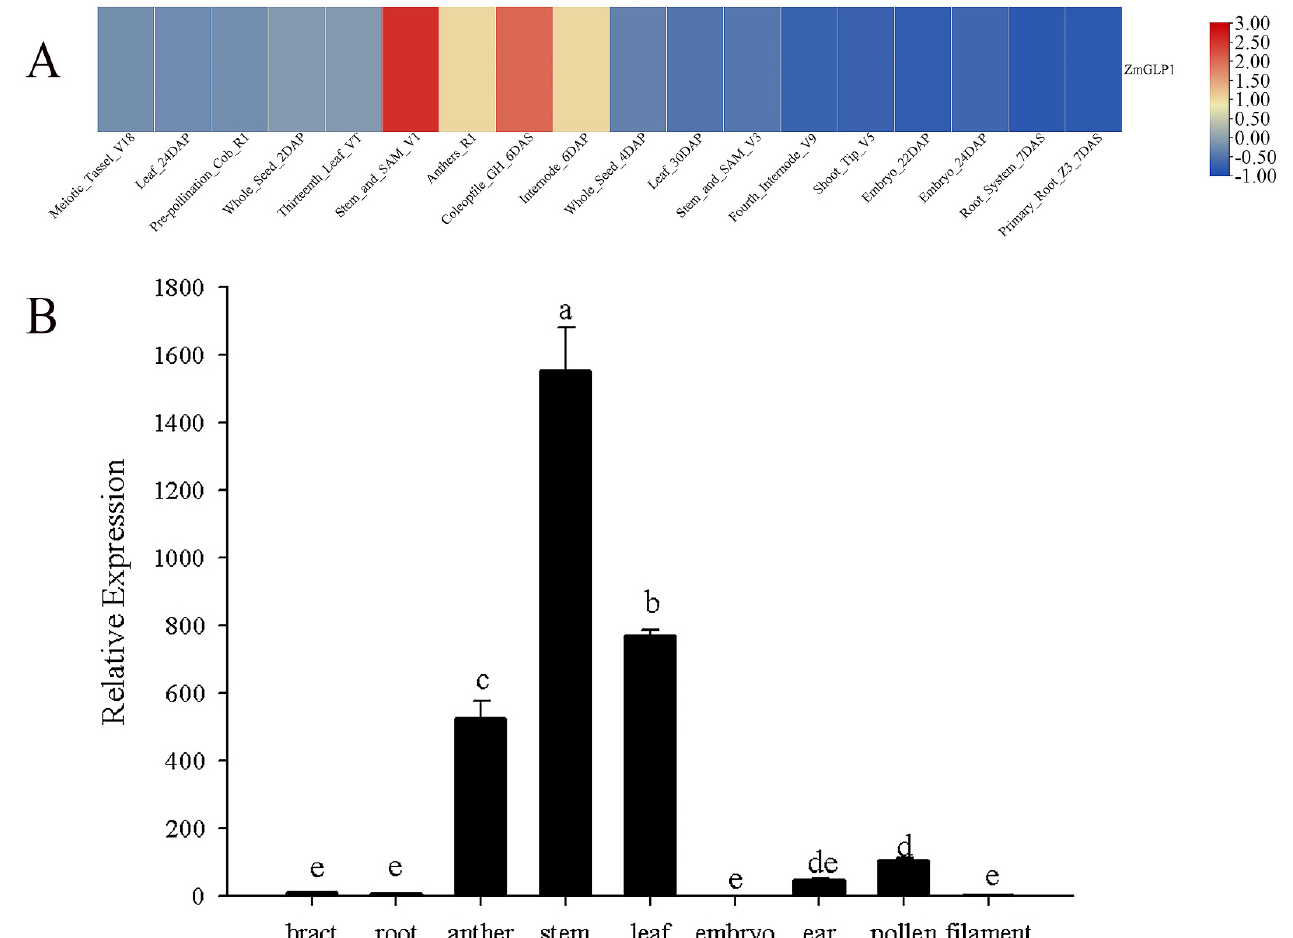
Figure 2. Expression analysis of ZmGLP1 in different maize tissues. ( A ) Heat map of tissue-specific expression of ZmGLP1 in maize. DAS = days after sowing; DAP = days after pollination. ( B ) Relative expression of ZmGLP1 in different maize tissues. Different letters in subfigure ( B ) indicated significant difference between different samples by Duncan’s post-hoc test. Data are presented as the mean ± SD based on three biological replicates.